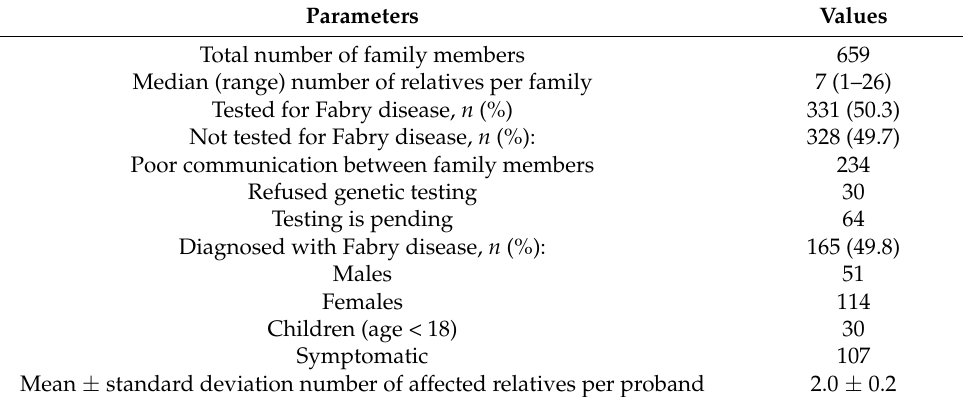
Table 2. Pedigree analysis in 83 probands with Fabry